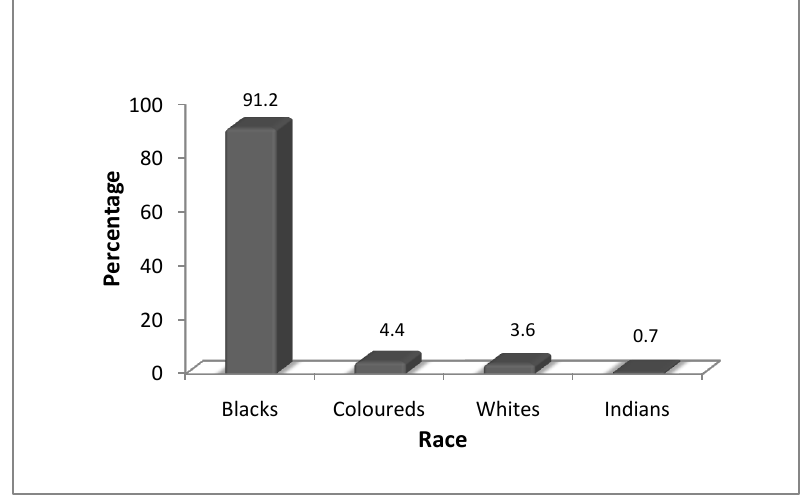
FIGURE 3: Race distribution of respondents, 2008. Source: Survey data